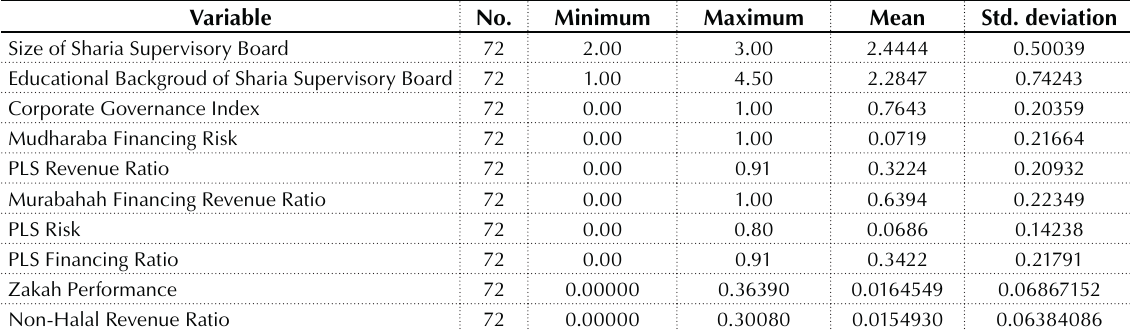
Table 1. Variable